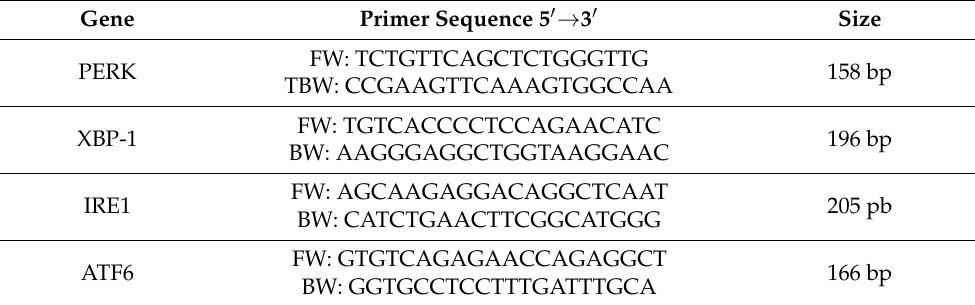
Table 1. Primers used for real-time RT-PCR. FW: Forward, BW: Backward (reverse primer).